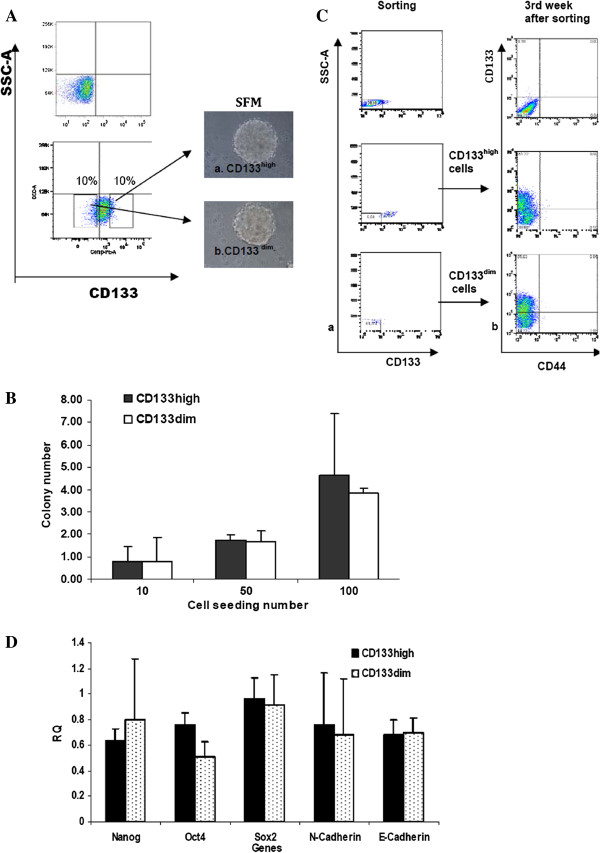
In vitro analysis of the stemness properties in sorted CD133high and CD133dim LC-42 cells. A. Cell sphere-forming assay under serum-free condition. 10% highest CD133+ cells and the lowest 10% CD133− were isolated via FACS. Spheres were generated from both sorted CD133high and CD133dim LC-42 cell populations within 3 weeks. Representative cell sphere images were acquired at 40× magnification. B. Colony-forming ability of different sorted LC-42 cell populations at different cell seeding numbers using soft agar clonogenic assay. The colony numbers of each cell population were compared at different cell seeding numbers. A direct relation between the number of cells seeded and number of colonies formed was observed. The clonogenic ability of different sorted cell populations showed no significant difference. The values of colony numbers of each cell population represented the average of three individual analysis. C. Recapitulate phenotype of the original LC-42 cells by post-sorting cell culture. FACS analysis of CD133 just following sorting (column a) and at the third week after sorting under the conventional cell culture condition (column b) showed the expressions of the CD133 in both CD133high and CD133dim cell fractions reached the similar level as its original LC-42 cells at the third week after sorting. D. Relative quantitative real-time PCR analysis of the expression of stem cell related genes Nanog, Oct4 and Sox2 in sorted CD133high and CD133dim LC-42 cell fractions. Real-time PCR assay revealed similar levels of these genes expression in CD133high and CD133dim cell fractions. The error bar reflected the variation within the triplicates.